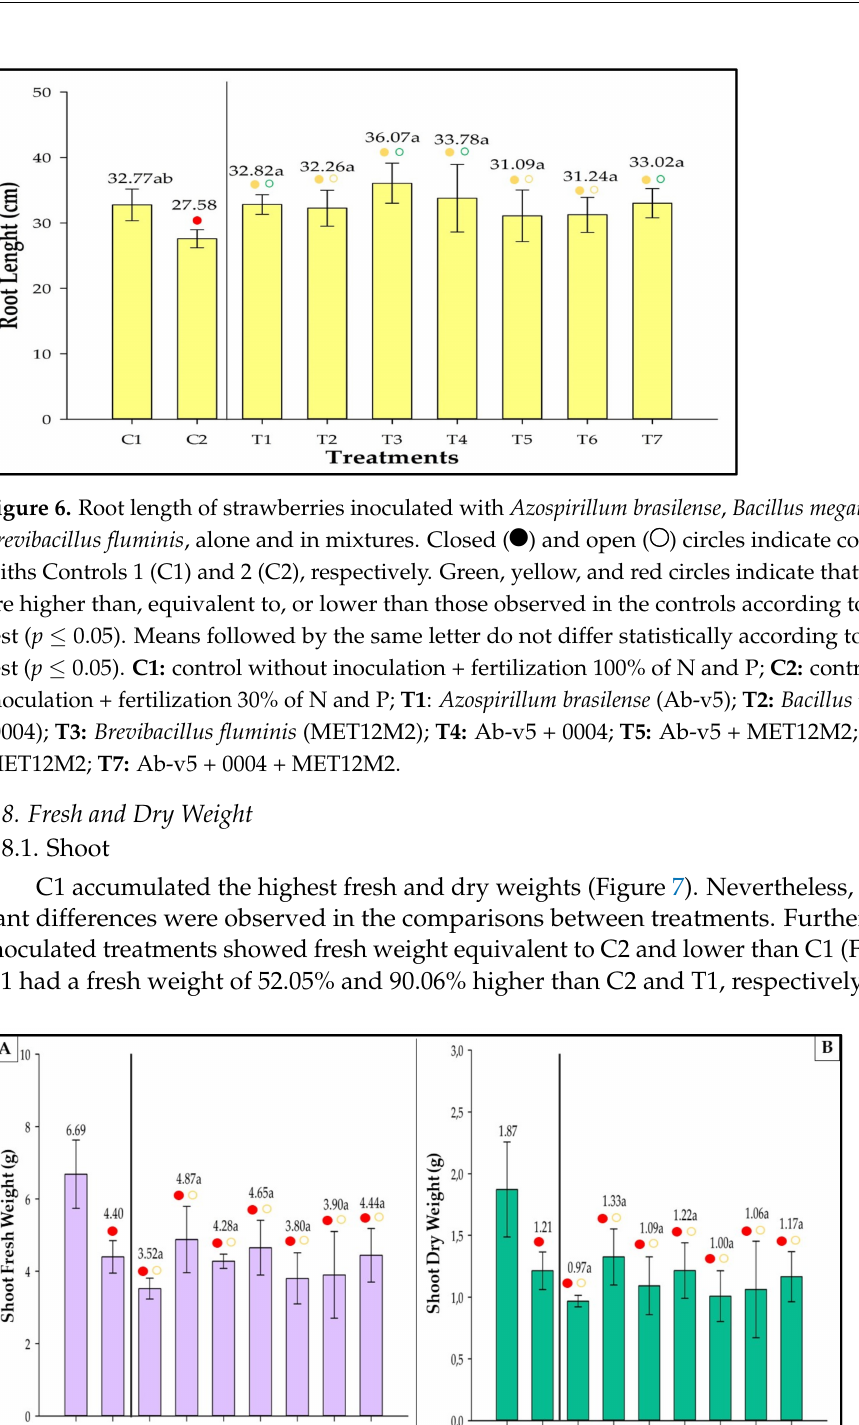
Closed ( ⬤ ) and open ( 〇 ) circles indicate comparisons withs Controls 1 and 2, respectively. Green, yellow, and red circles indicate that the values are higher than, equivalent to, or lower than those observed in the controls, according to the Kruskal–Wallis test ( p ≤ 0.05) and pairwise comparison with the Dunn test ( p ≤ 0.05). Means followed by the same letter do not differ statistically. Control 1: control without inoculation + fertilization 100% of N and P; Control 2: control without inoculation + fertilization 30% of N and P; Treatment 1: Azospirillum brasilense (Ab-v5), Treatment 2: Bacillus megaterium (0004); Treatment 3: Brevibacillus fluminis (MET12M2); Treatment 4: Ab-v5 + 0004; Treatment 5: Ab-v5 + MET12M2; Treatment 6: 0004 + MET12M2; Treatment 7: Ab-v5 + 0004 + MET12M2.